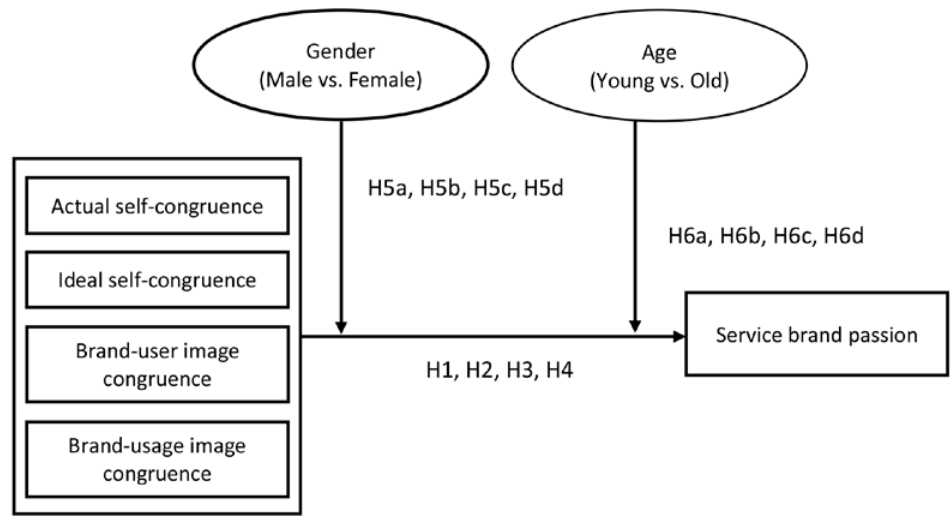
Figure 1. Proposed theoretical framework